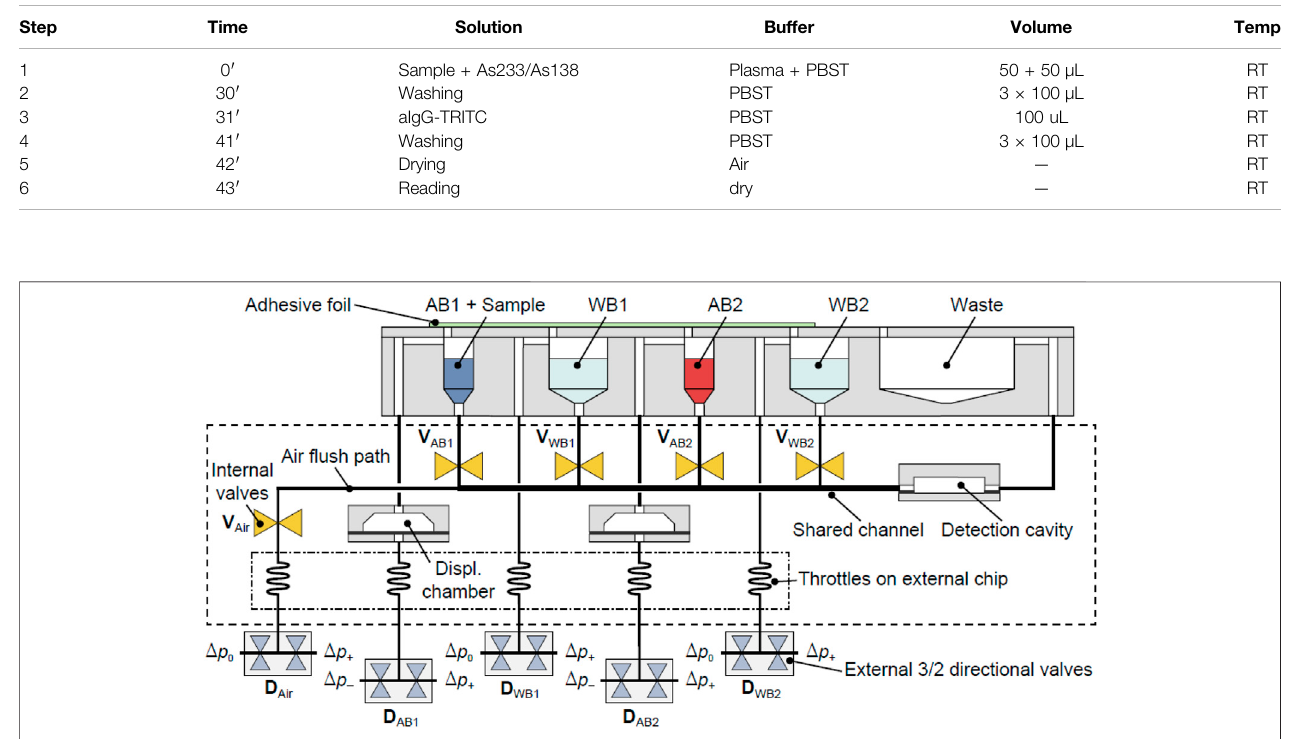
FIGURE2| Schematicmicro fl uidiclayoutemployedtoperformanimmunoassay.InternalandexternalvalvesarelabeledasVandD,respectively.Controlvalvesto switch between positive ( p +) and negative ( p +) differential pressure and atmospheric pressure (p0) are indicated. AB1+sample reservoir content the sample plus the cocktail of antibodies used for the assay (As233 and As138) in their corresponding concentration in PBST. AB2 reservoir is used to contain the secondary antibody labeled with TRITC (aIgG-TRITC). WB1 and WB2 reservoir are fi lled with